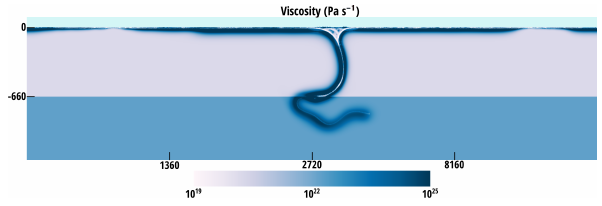
Figure 2. Piled slab descending into the lower